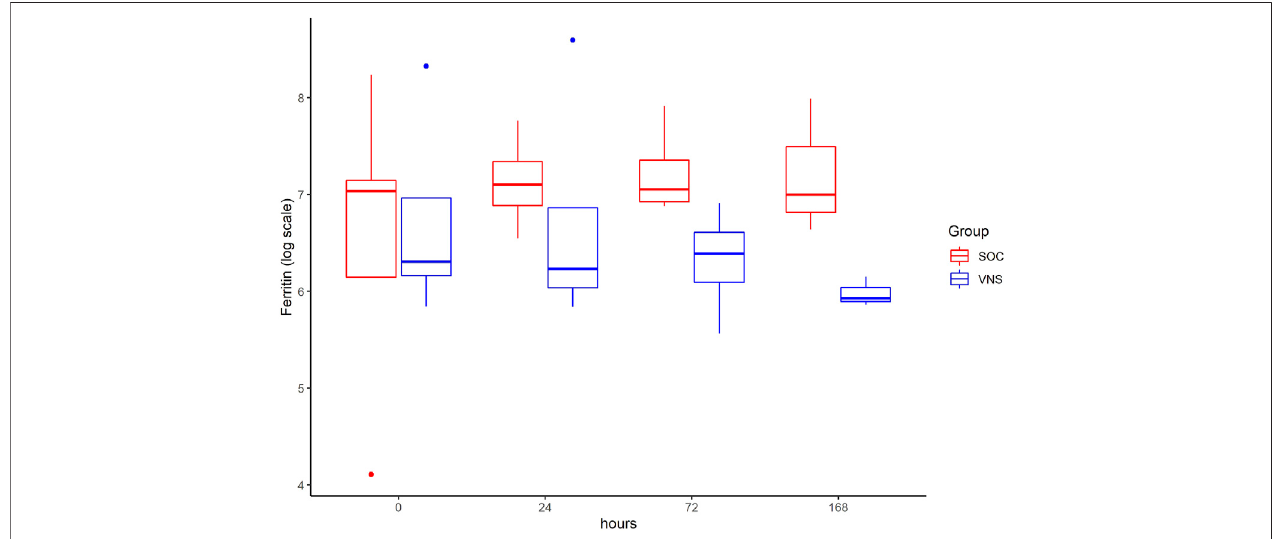
FIGURE7| Median ferritin level with Interquartile Rangeofpatientsreceivingauricular VagusStimulation (VNS =blue)and patients only receiving Standard ofCare (SOC = red) after 0, 24, 72, and 168 h of study inclusion.